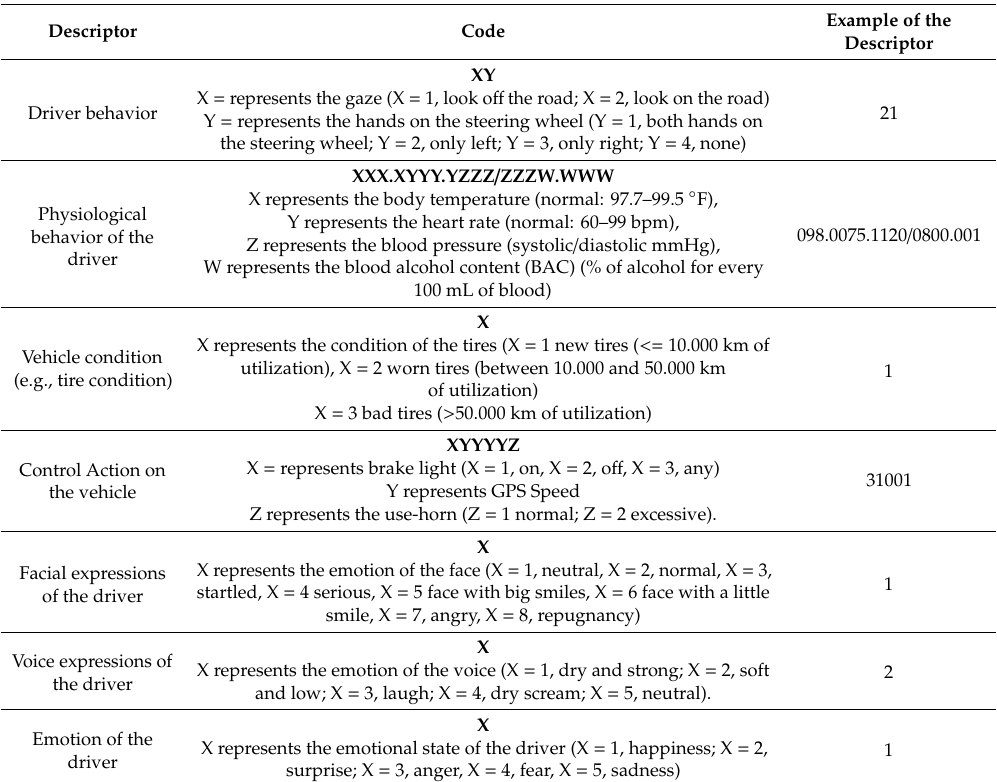
Table 5. Conceptual view of emotion